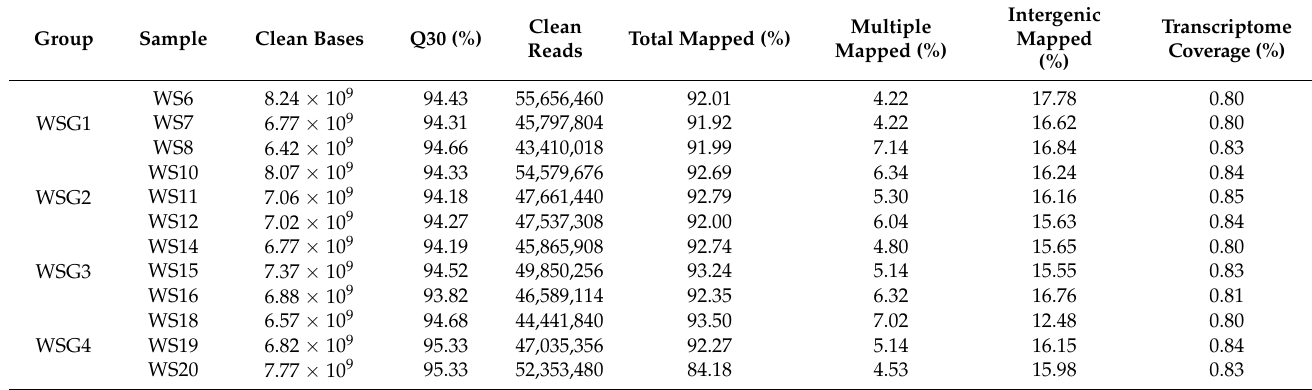
Table 1. Quality control and mapped results of sequencing data.